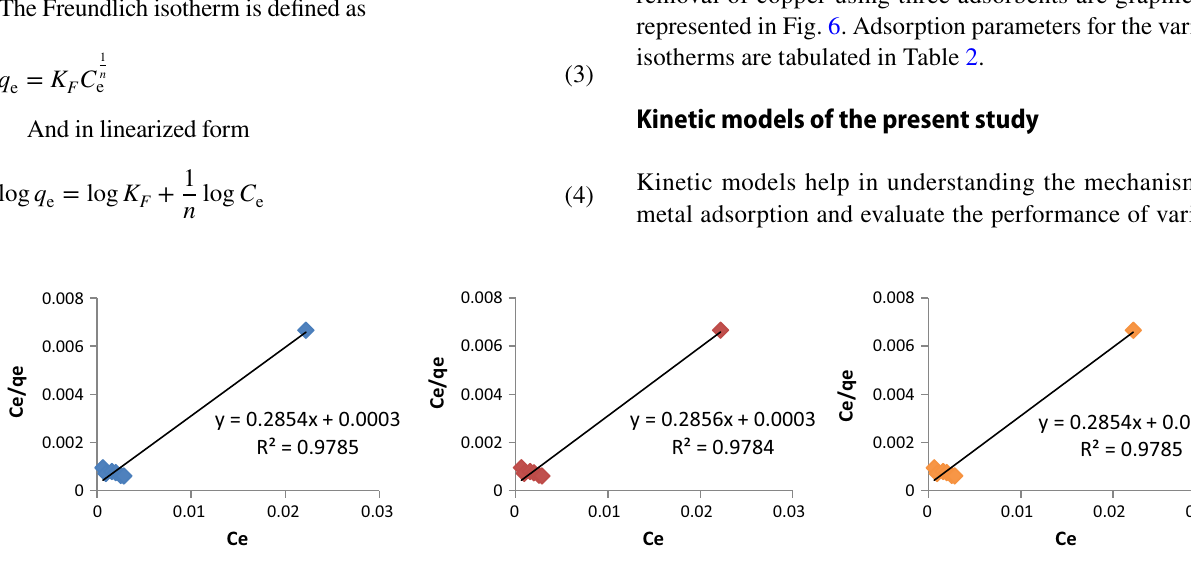
Fig. 4 Langmuir adsorption isotherms for the removal of Cu(II) using GNSCP, SSCP and CCP